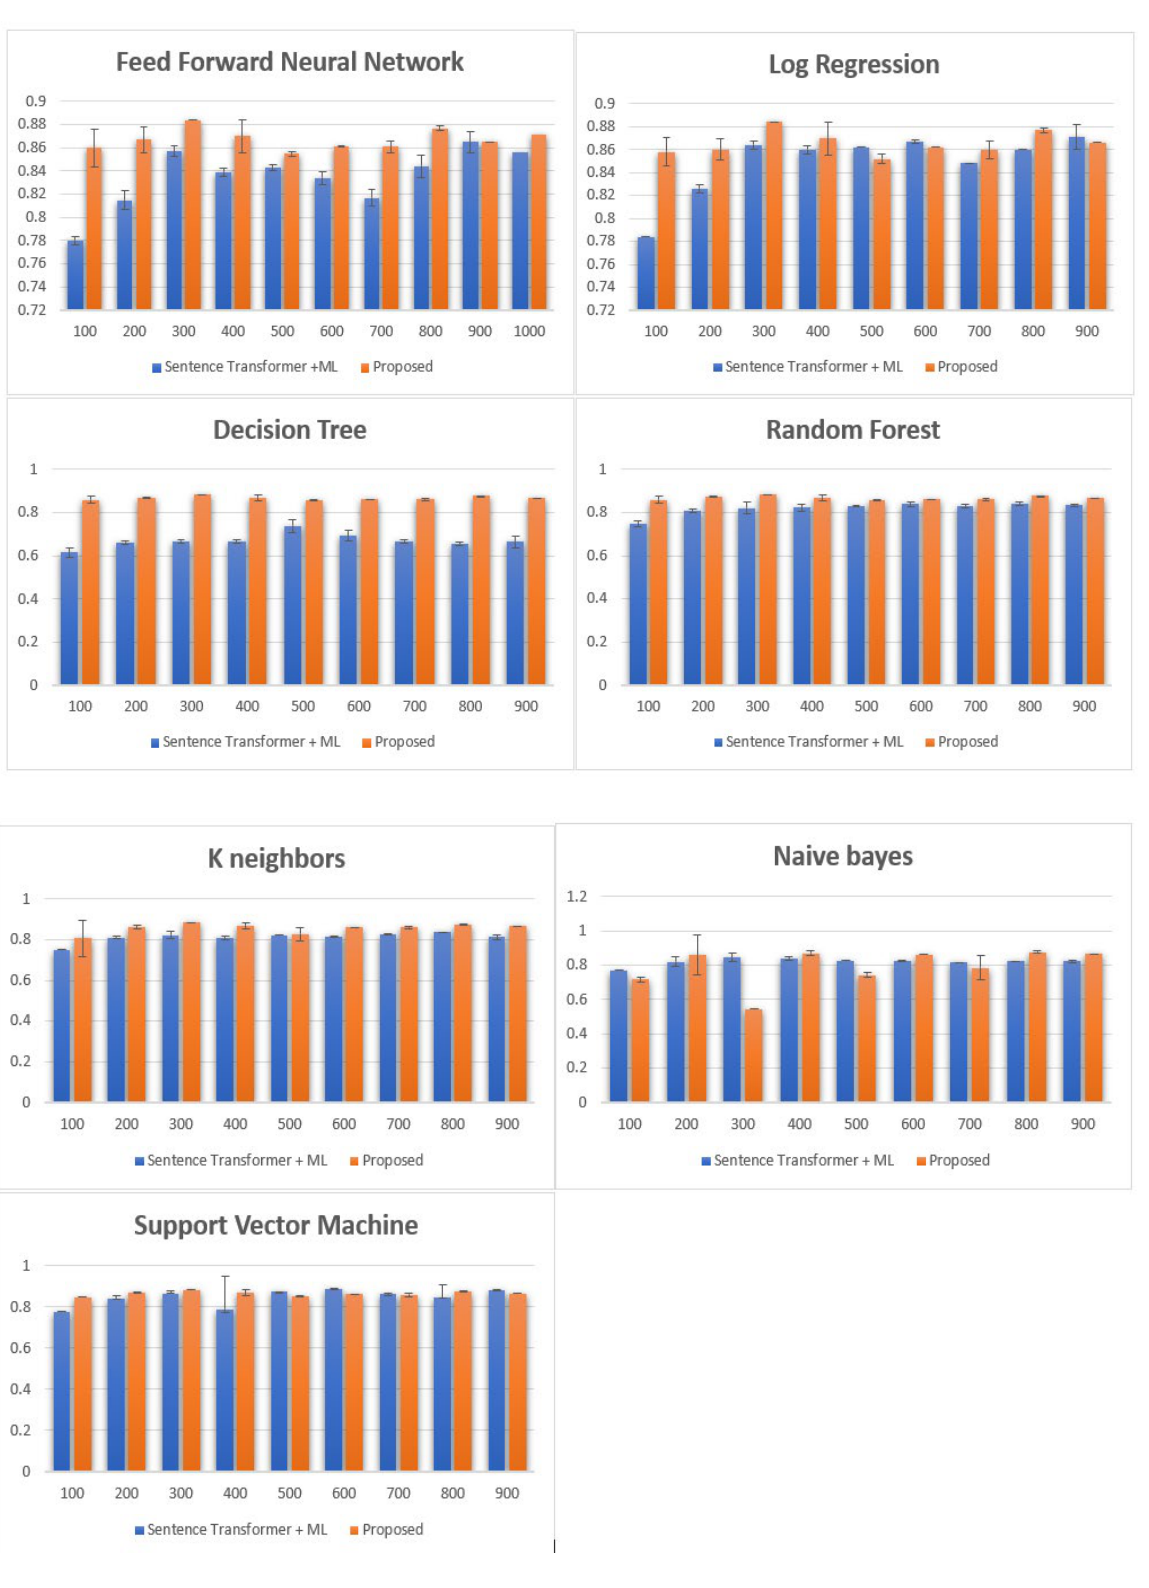
Figure 7. Accuracy vs. number of training instances for sentence transformer + machine learning classifiers and our proposed method.